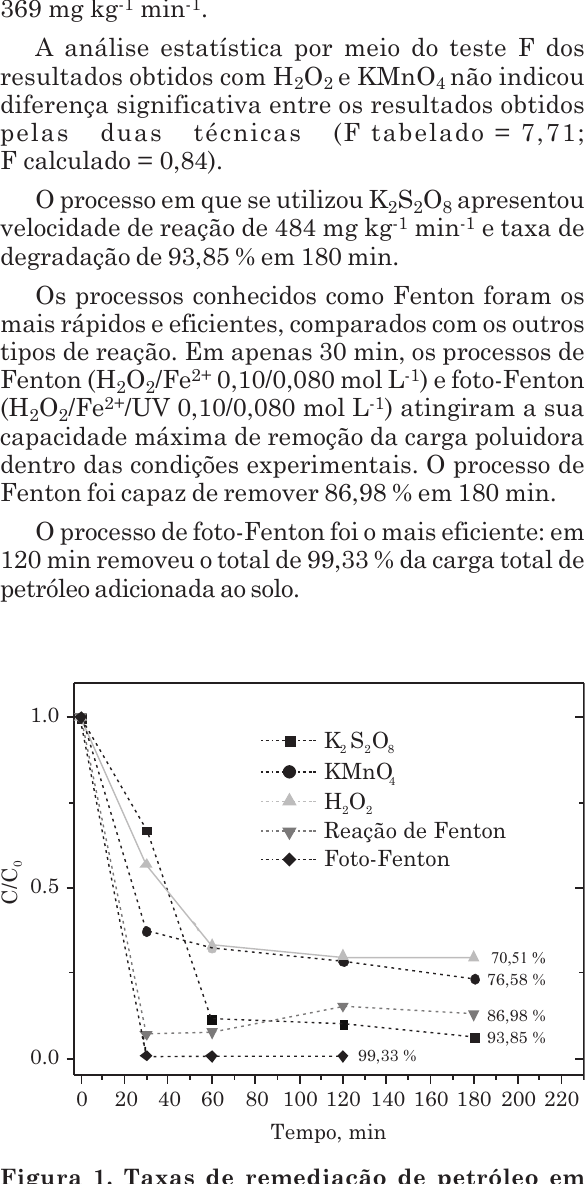
Figura 1. Taxas de remediação de petróleo em Latossolo